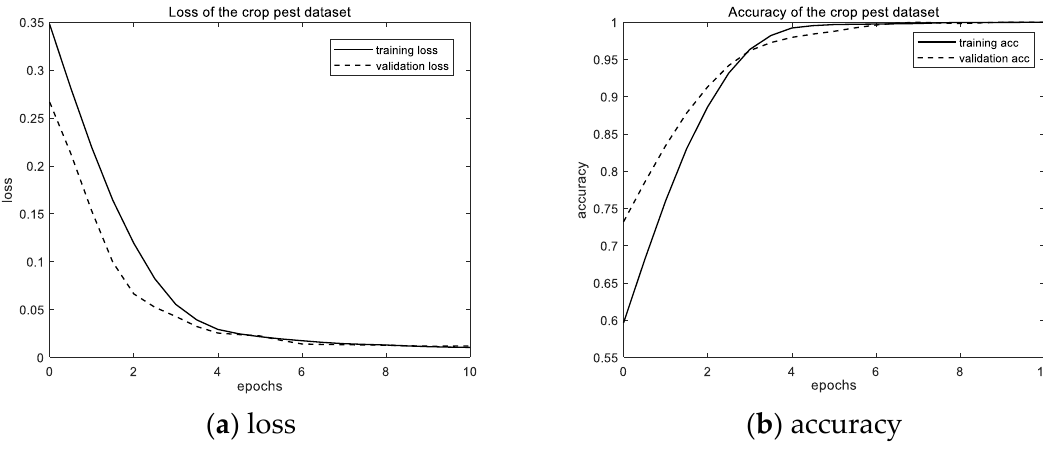
Figure 8. The loss and accuracy on the crop pest dataset.